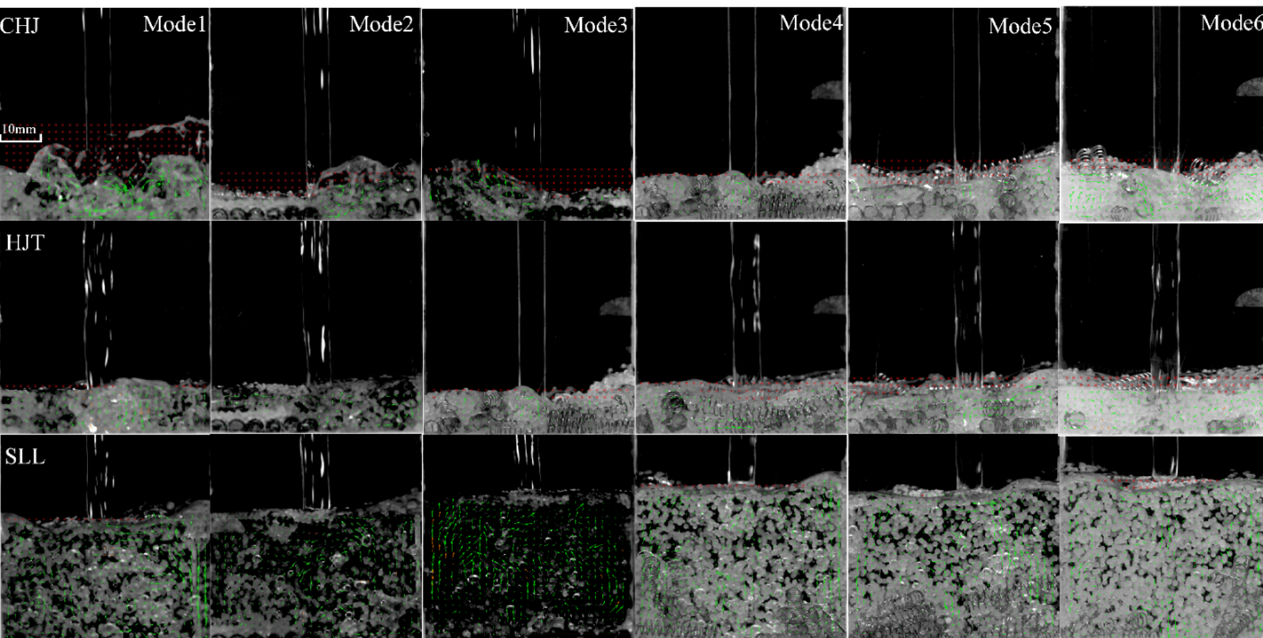
Figure 7. The hydraulic jump form and flow field in three physical forms of the hydraulic jump of the front view (casting speed of 2.4 m/min, modes 1–6).